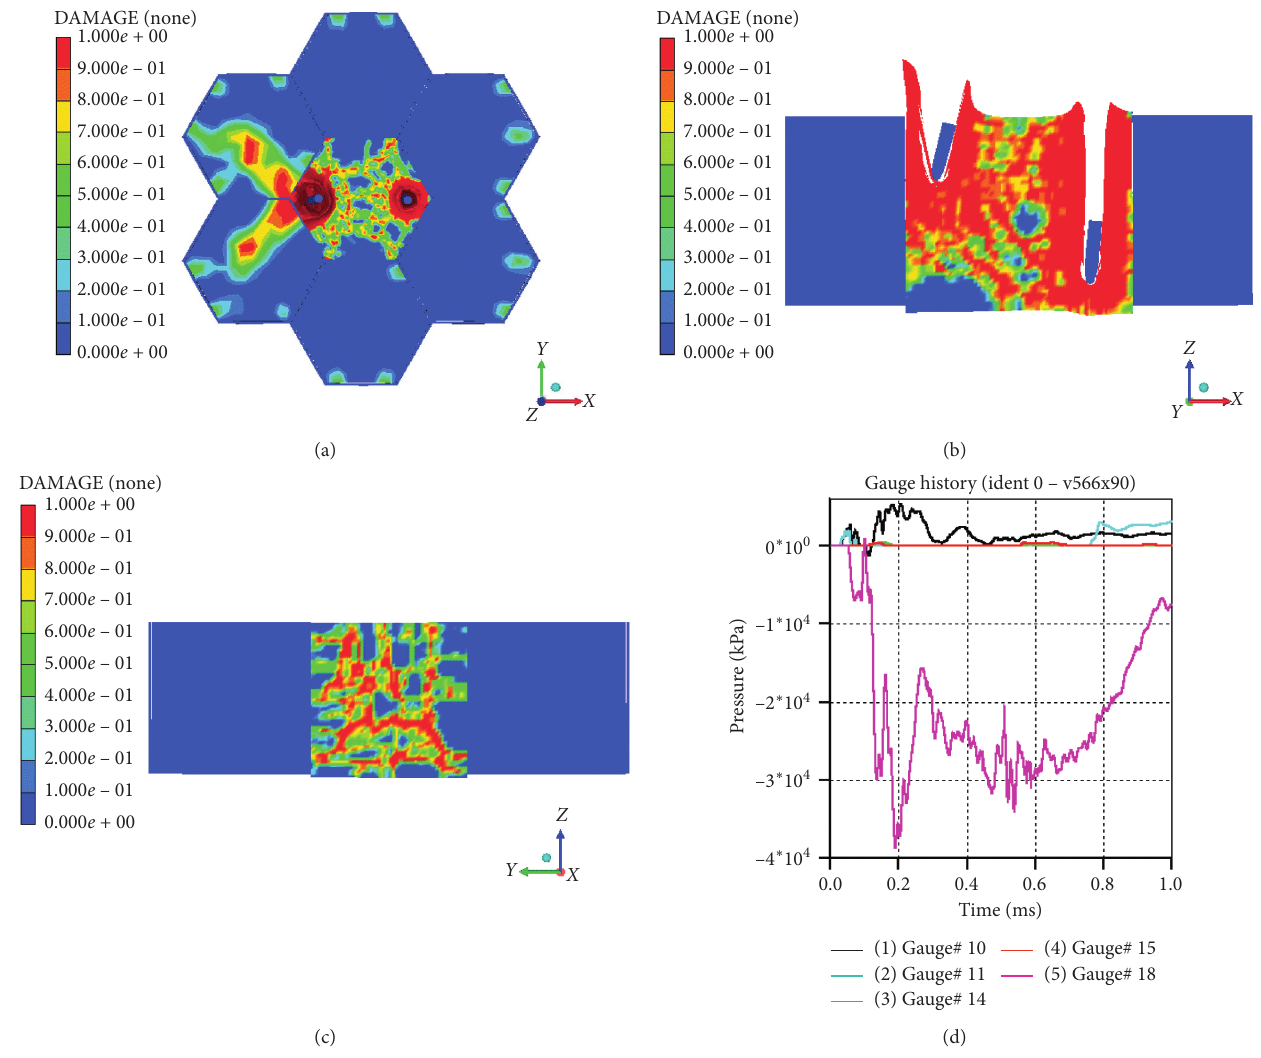
Figure 10: Target damage under configuration set 3 ( t � 1 ms): (a) front view, (b) section view by XZ plane, (c) section view by YZ plane, and (d) gauge history.